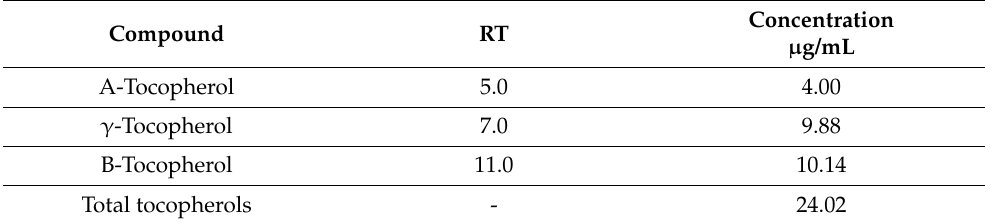
Table 2. Tocopherol content of Opuntia ficus-indica seed